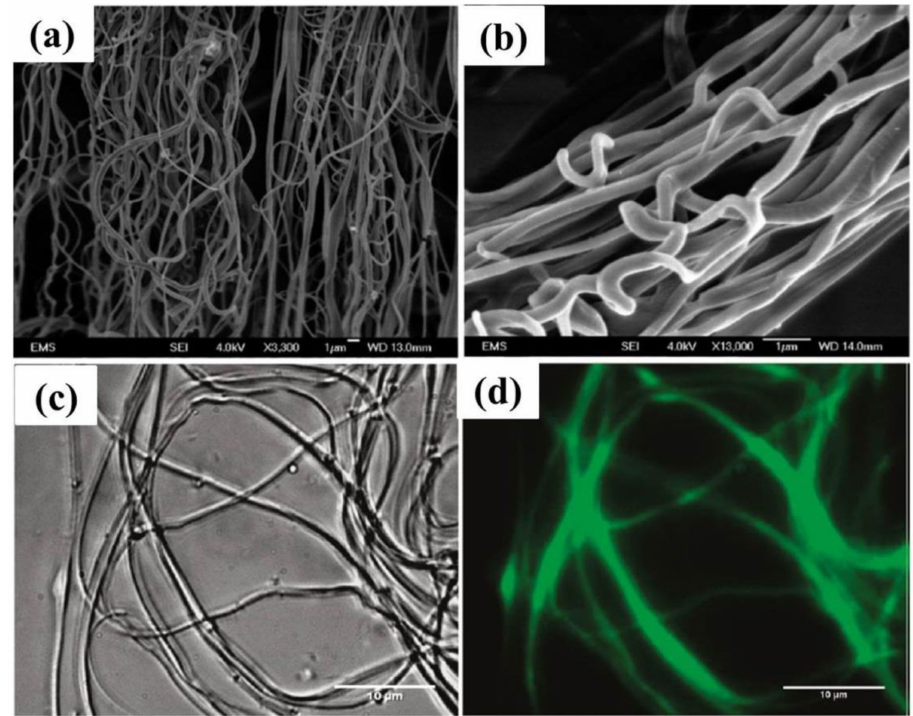
Figure 16. ( a , b ) SEM images of SPI/Nylon 6 blend monolithic fibers; ( c , d ) optical and fluorescent images of the same fibers, respectively, where the green color in image ( d ) proves the existence of SPI in fibers [248]. Reproduced with permission from ref. [248]. Copyright American Chemical Society,